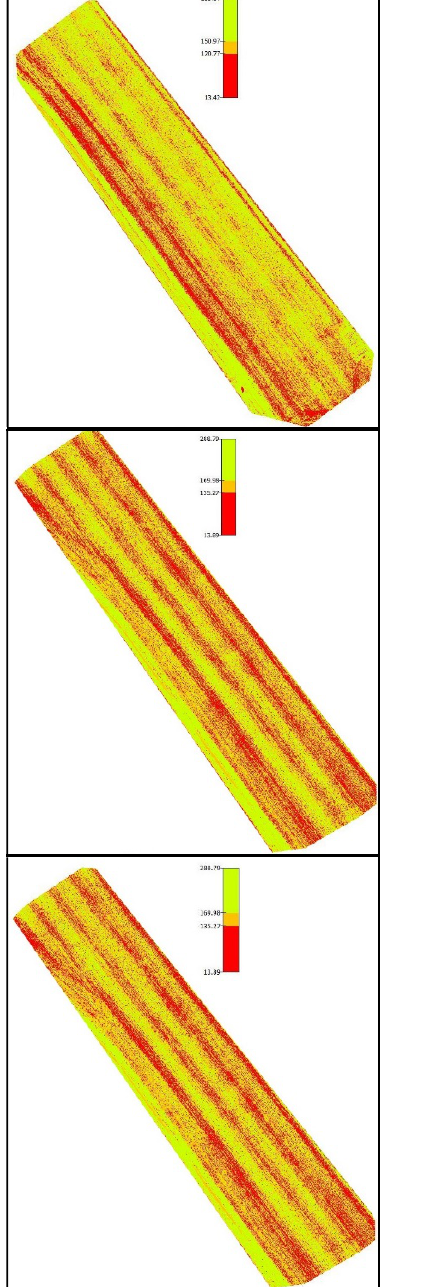
Figure 3 – VARI maps for wheat crops (A – germinating, B –